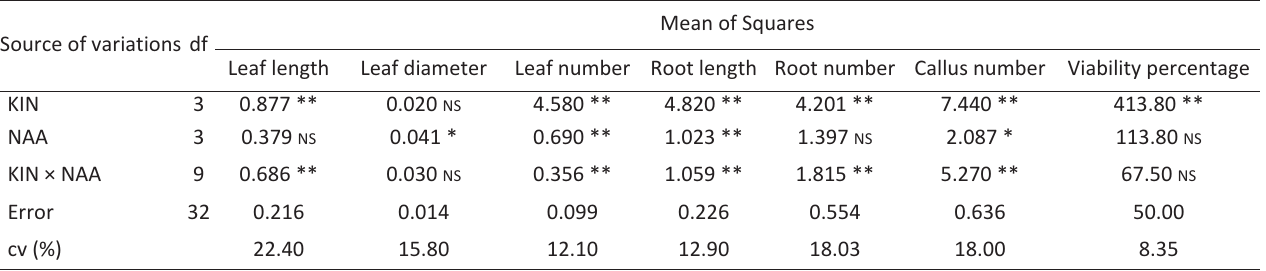
Table 1 ­ Analysis of variance of the effect of different concentrations of KIN and NAA on measured characters of Fritillaria imperialis L.